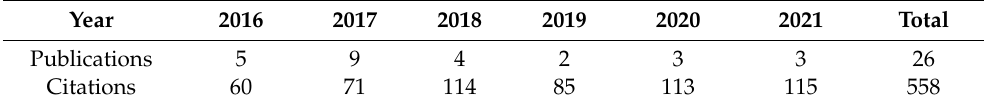
Table 4. Publication and citation counts based on the analysis pattern: TS = ((oil OR petroleum) AND energy security educ*). Source: Web of Science database.